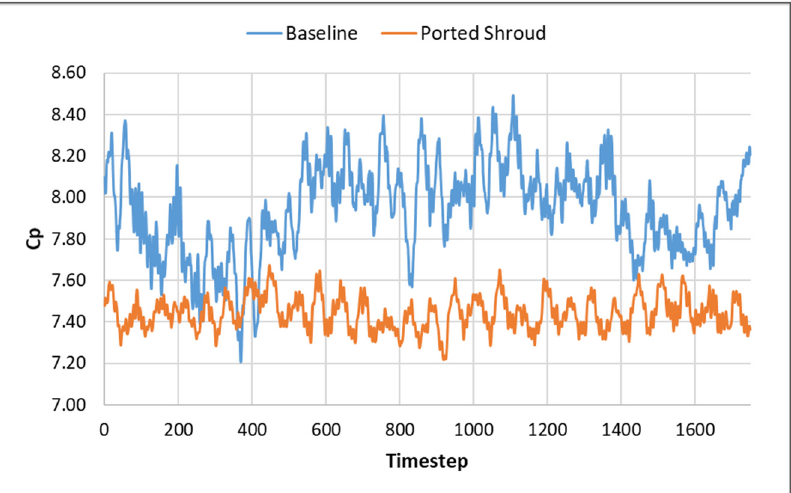
Figure 22. Instantaneous C p data at the rotor outlet for the configurations with ported shroud and baseline (last 35 rotor revolutions for operating point OP3).